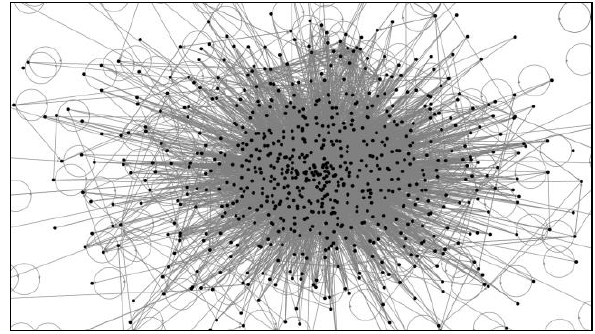
Figure 2. Graph visualization of the extracted information #nuevoaeropuerto